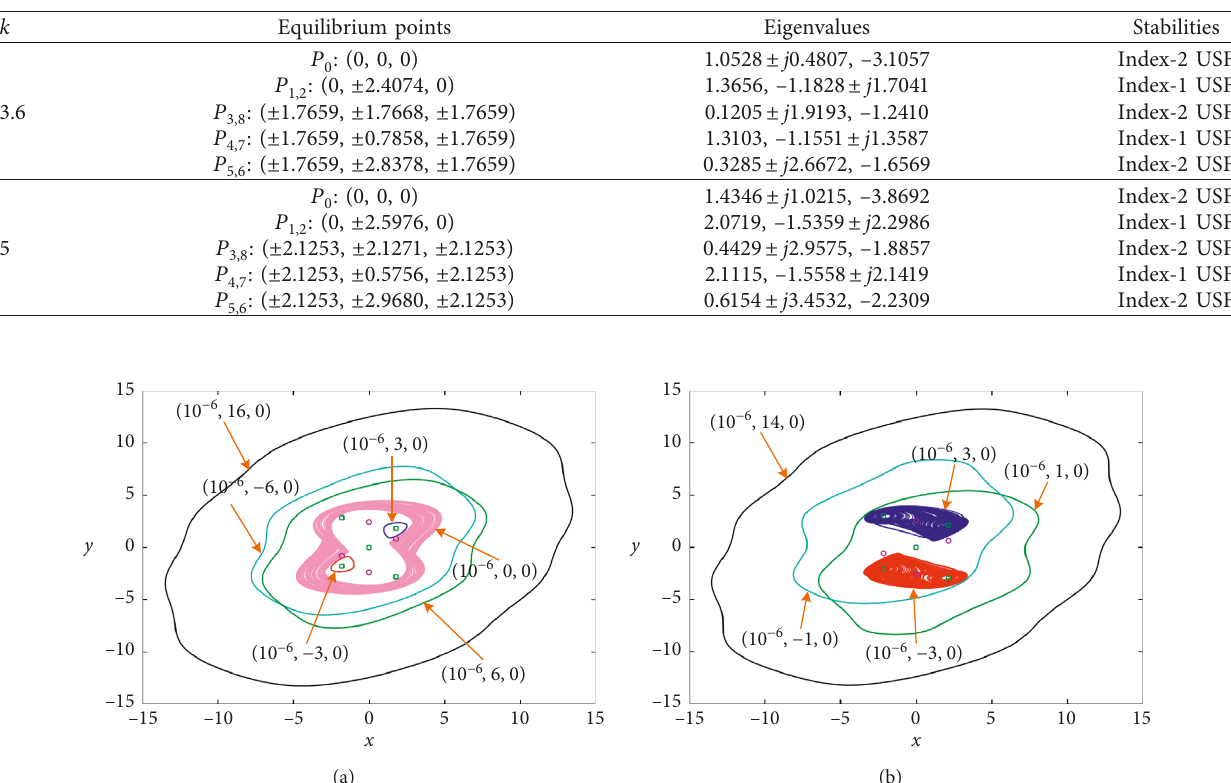
5, five types of coexisting multiple (cid:31)